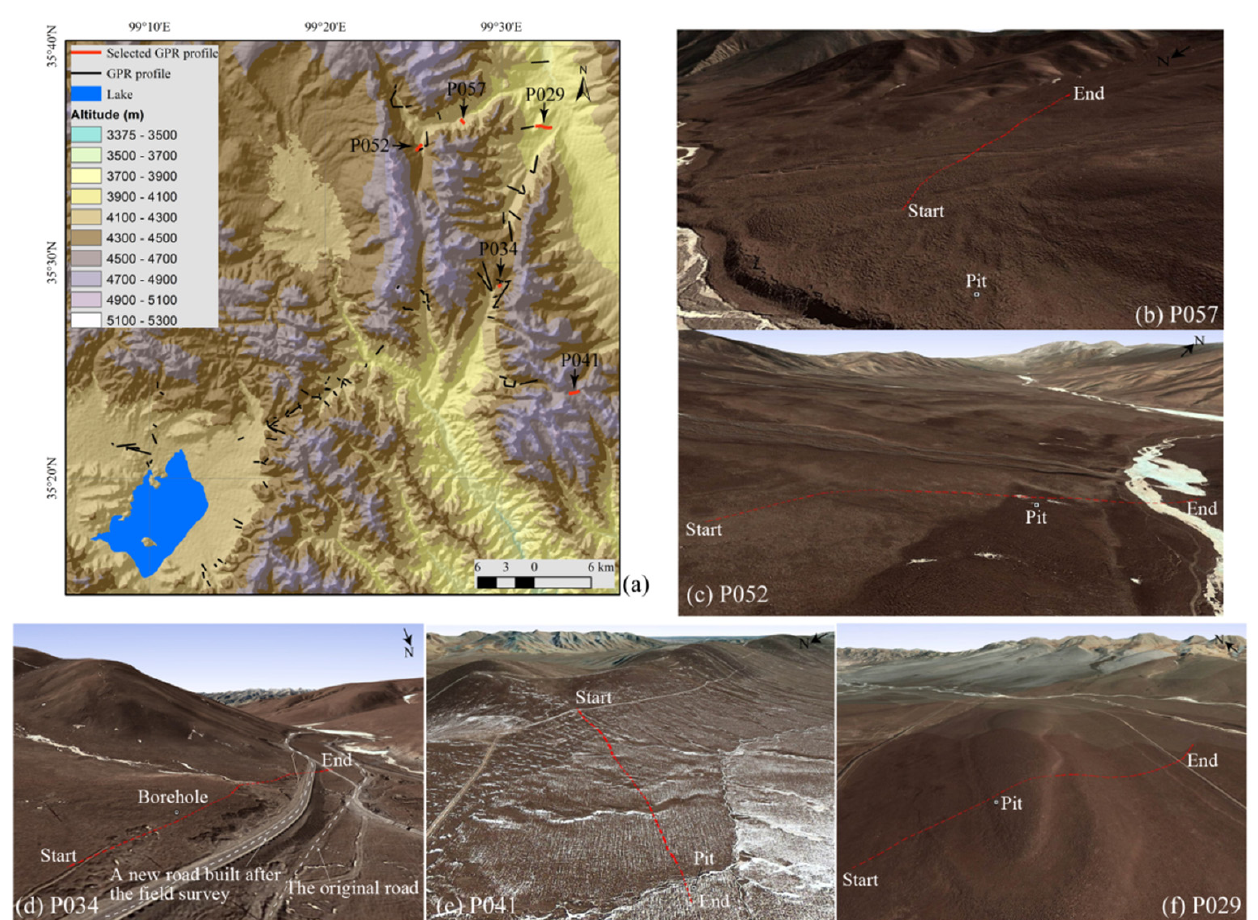
Figure A1. ( a ) The locations of all GPR profiles involved in this article; ( b – f ) correspond to the GPR profiles P057, P052, P034, P041, and P029, which are displayed in Google Earth, respectively. When